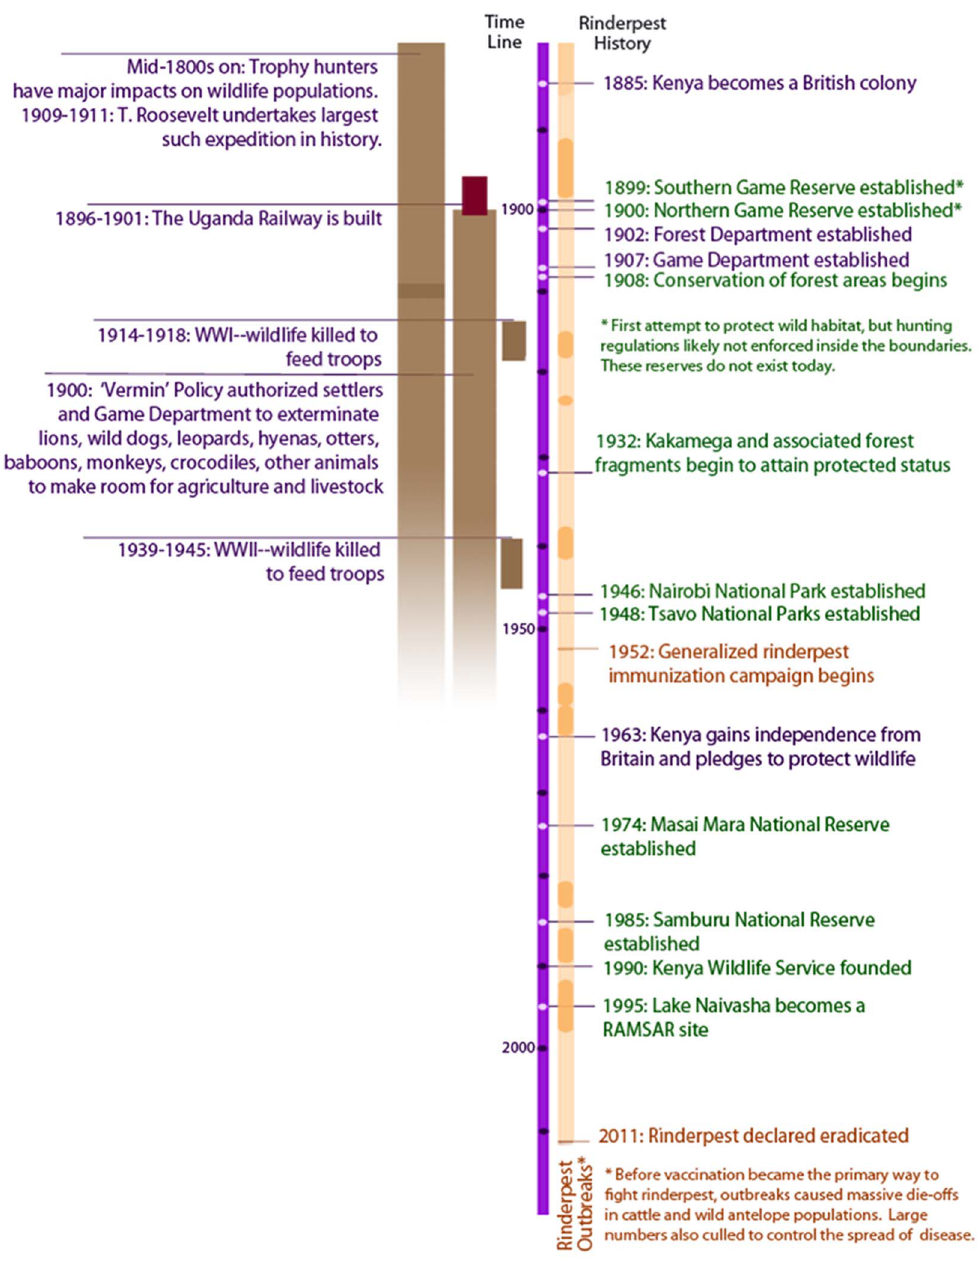
Figure 2. Kenya’s wildlife policies. A timeline summarizing Kenya’s policy on natural resources and wildlife over the past 120 years [11,18].